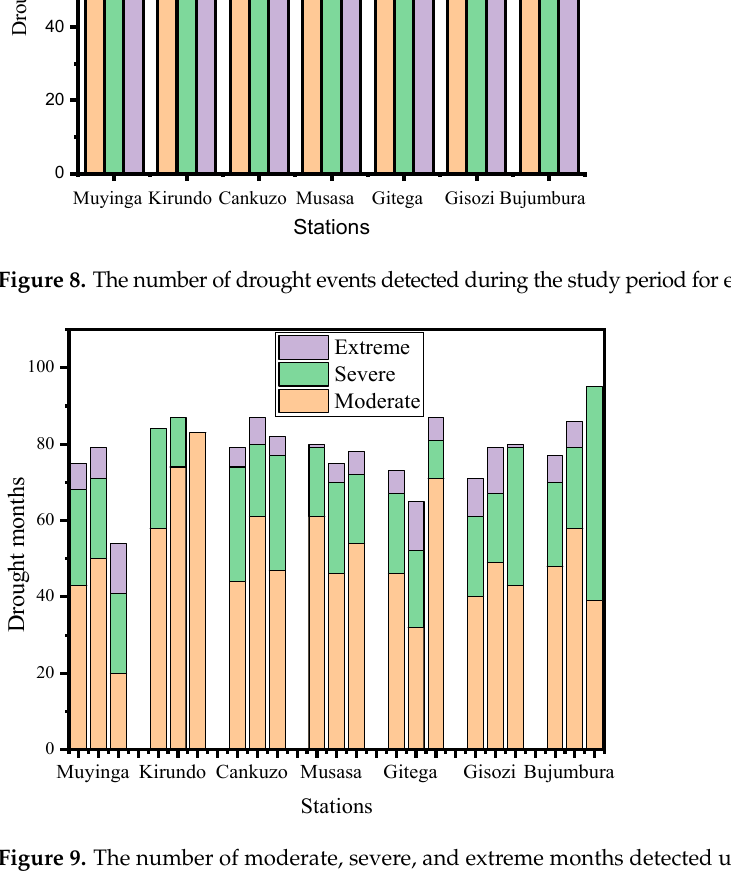
Figure 9. The number of moderate, severe, and extreme months detected under SPEI timescales of 2, 6, and 24 months, respectively, for each